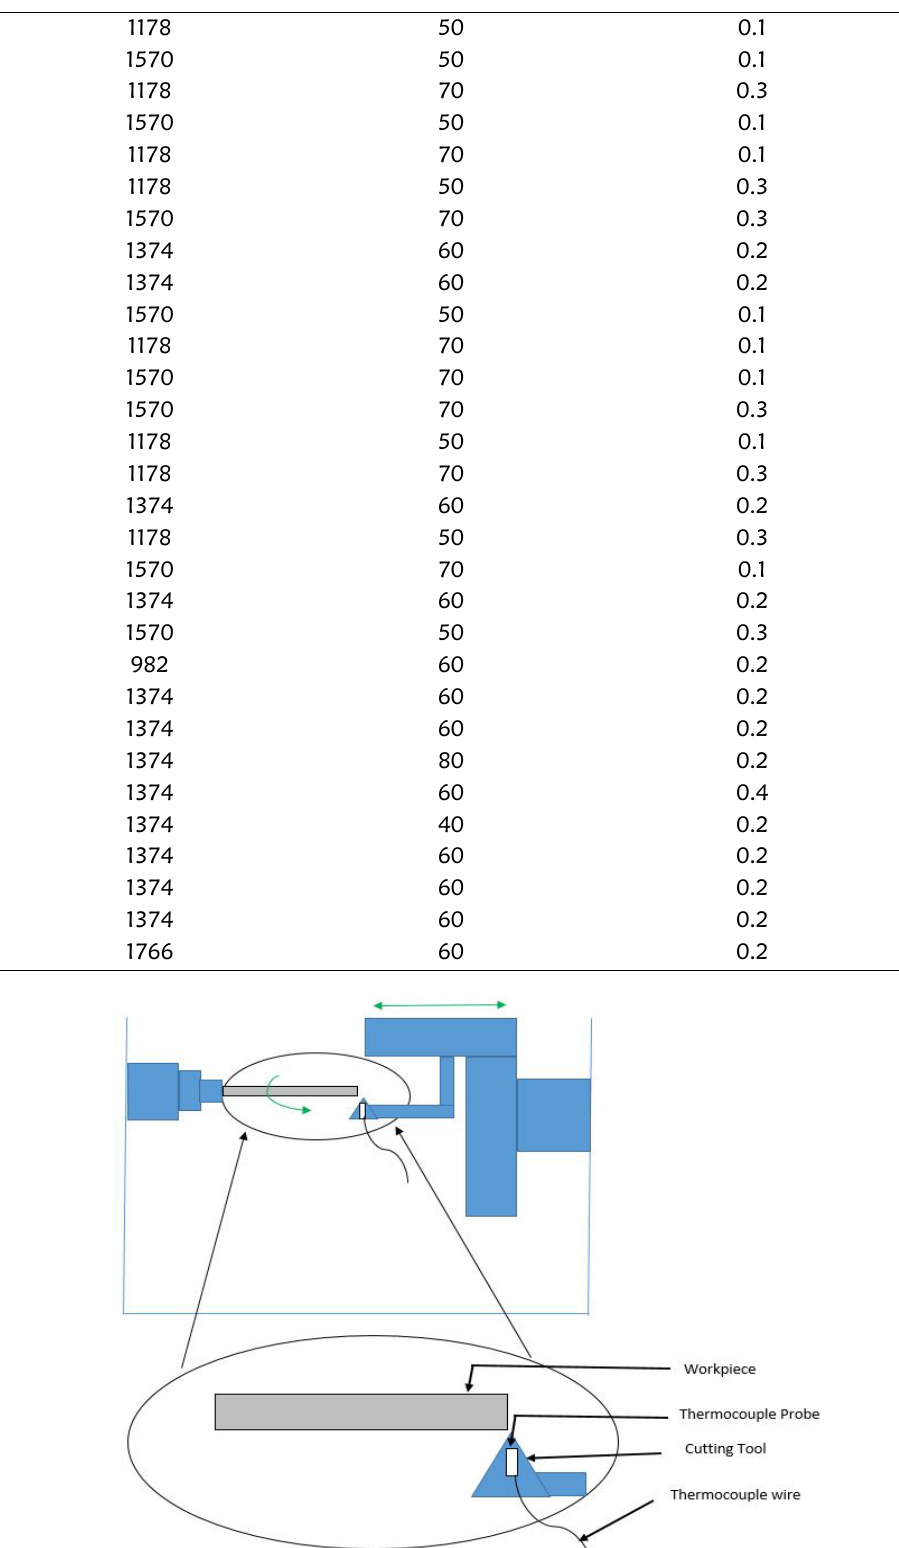
Figure 3: Experimental Setup showing probe